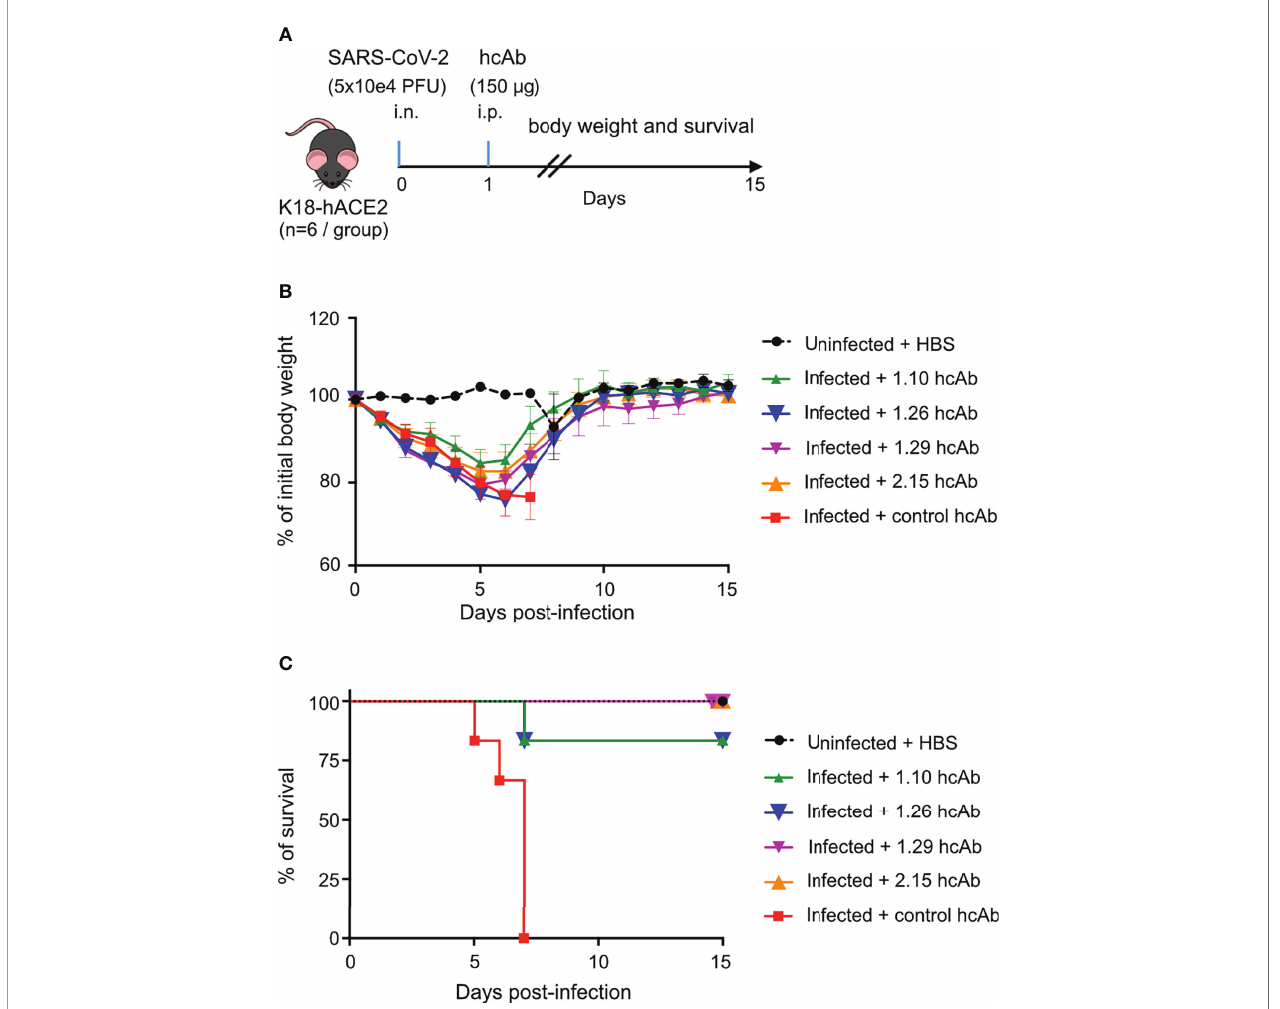
FIGURE 4 | hcAbs protection of hACE2-trangenic mice after a lethal SARS-CoV-2 infection. (A) In vivo experiment design. On day 0, groups of K18-hACE2 mice (n=6/group) were either infected intranasally (i.n) with a lethal dose of 5x10 4 plaque forming units (PFU) of SARS-CoV-2 (infected groups) or mock infected with PBS (uninfected group). On day 1 postinfection, 150 m g of 1.10, 1.26, 1.29, 2.15 or control hcAbs, were administered intraperitoneally (i.p.) to animals in the infected groups. The uninfected group was treated i.p. with HBS. (B) Percentage of daily body weight of animals in each experimental group (as indicated) relative to their body weight on day 0, before infection. Mean and SD of 6 animals. (C) Percentage of daily mice survival in each experimental group up to 15